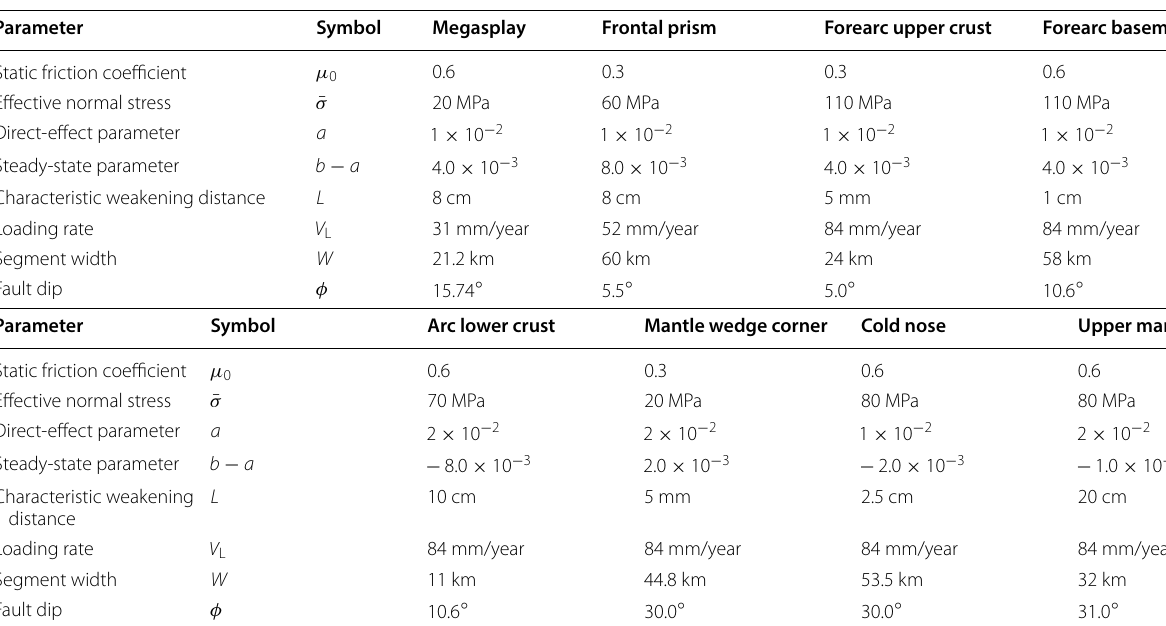
Table 1 Summary of the physical parameters controlling fault dynamics